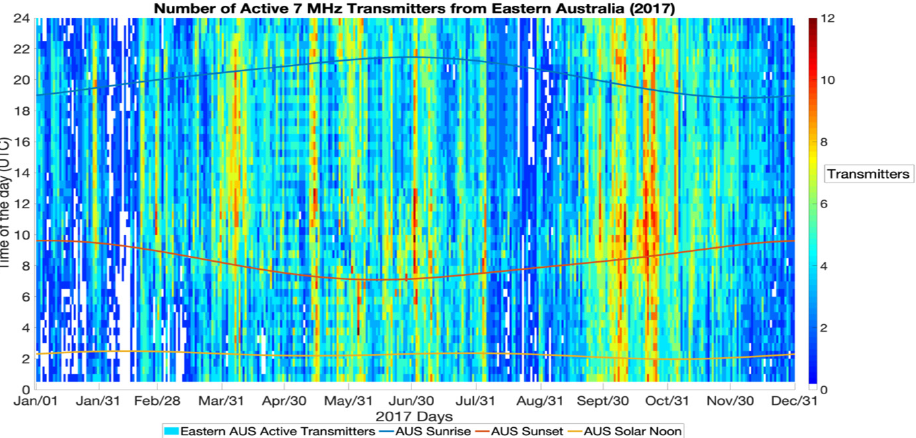
Figure 10. Number of active Eastern Australia WSPR transmitters in 2017. Only transmitters with a proven capability to cover the distance from Eastern Australia to the UK are shown. The colours indicate the number of transmitters available in each half-hour interval.